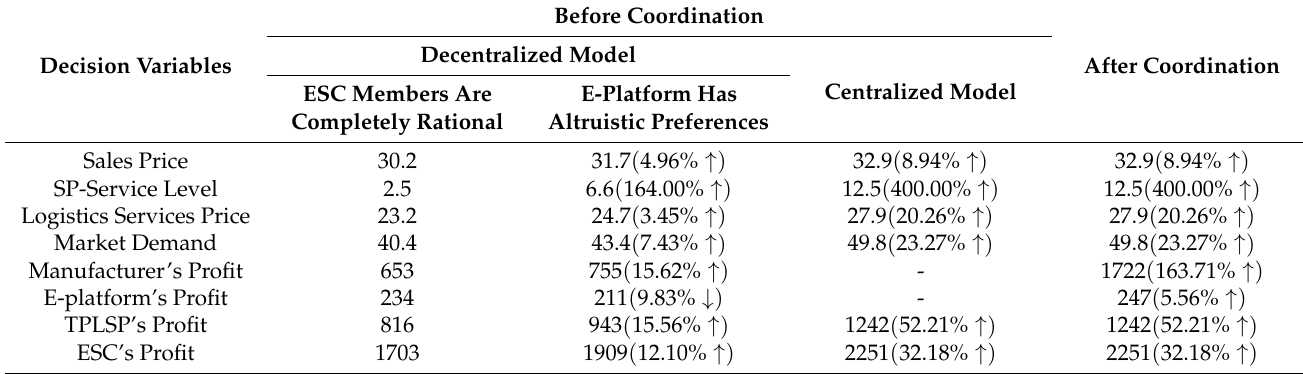
Table 4. Parameter values and change rates before and after coordination.